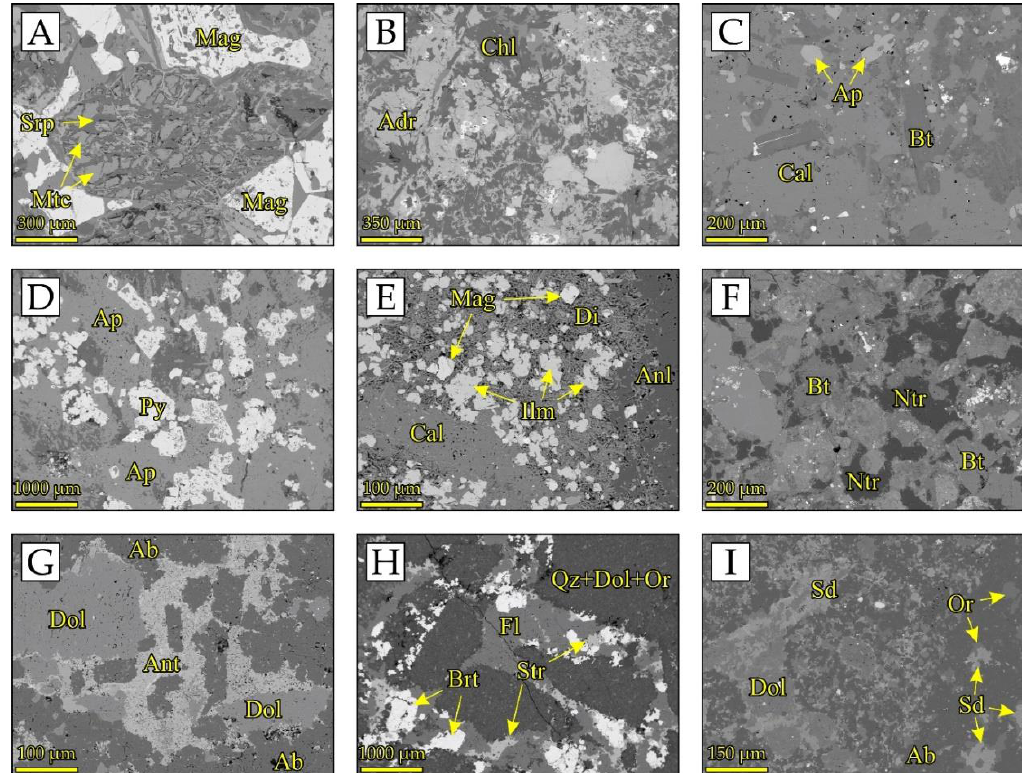
Figure 11. ( А – F ) The minerals of the studied rocks of the Kontozero complex: Ab — albite; Adr —